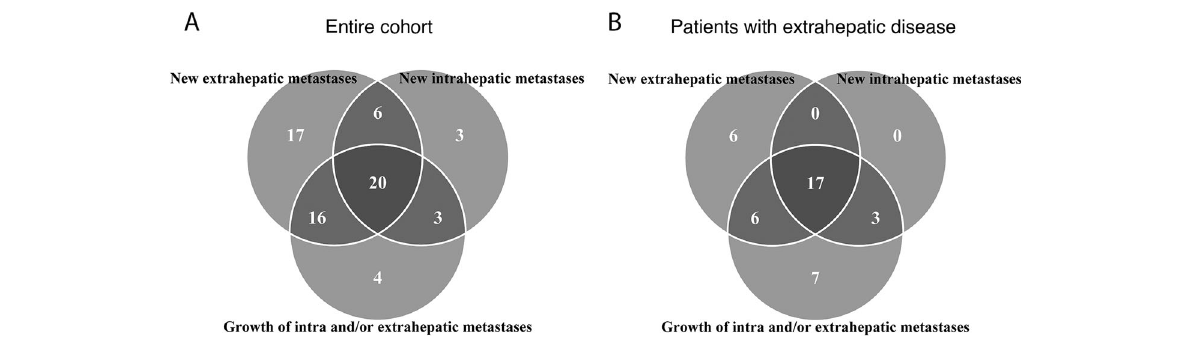
Fig. 2 Mode of progression of the entire cohort (90 patients) ( a ) and specifically for patients with extrahepatic disease at baseline (42 patients) ( b ). Numbers indicate the number of patients in the indicated (overlapping)